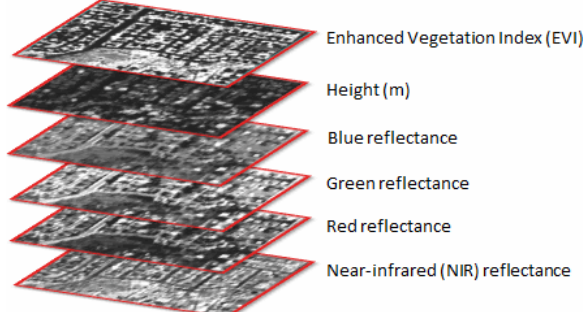
Figure 4. Example of a multi-band attribute image, where each band represents a different